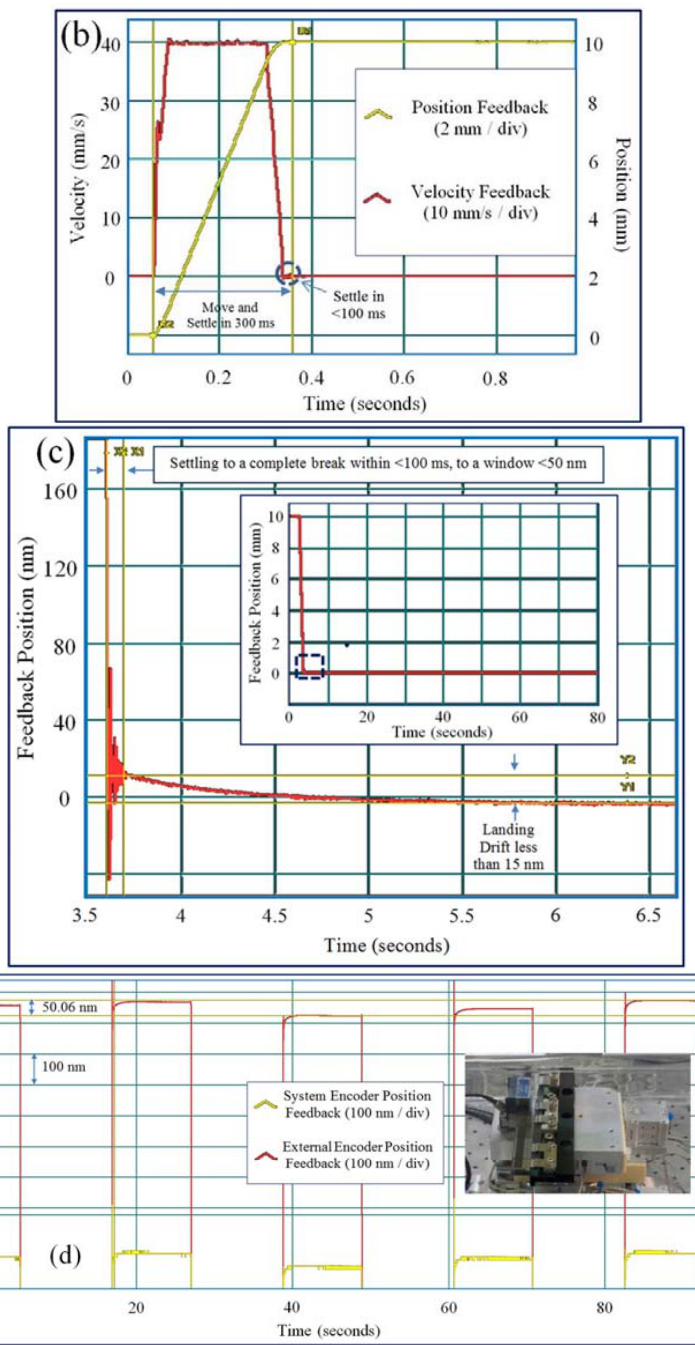
Figure 8. Example of high accuracy fast positioning, using an, L1B2 motor based, linear motion stage, with a moving weight of 0.5 kg. The performance shown is of a NM stage FB75-100-HR8 driven by a NM HR8-V vacuum motor (containing eight L1B2 elements) and equipped with an optical encoder position feedback (encoder resolution is 10 nm). The red colored graphs are all taken with an external reference encoder having a resolution of 0.1 nm. ( a ) An image of the FB75-100-HR8 stage. ( b ) Stage position and velocity as function of time, showing a typical 10 mm motion step, accomplished within 300 ms. ( c ) Feedback position during break, showing a (complete break) settling to a window less than 50 nm from target within 100 ms, followed by a landing drift of less than 15 nm during the next 3 s. ( d ) Position as function of time during sequential back and forth 10 mm moves. The graph focuses around the landing position at one of the two motion ends, showing a landing repeatability window of less than 50 nm.